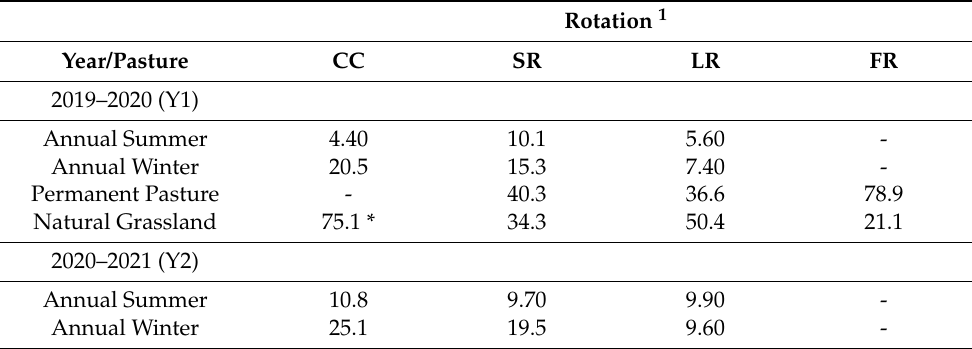
Table 8. Occupation of pastures (% of time per year) in the ‘Palo a Pique’ pasture–crop rotations long-term experiment in Treinta y Tres,